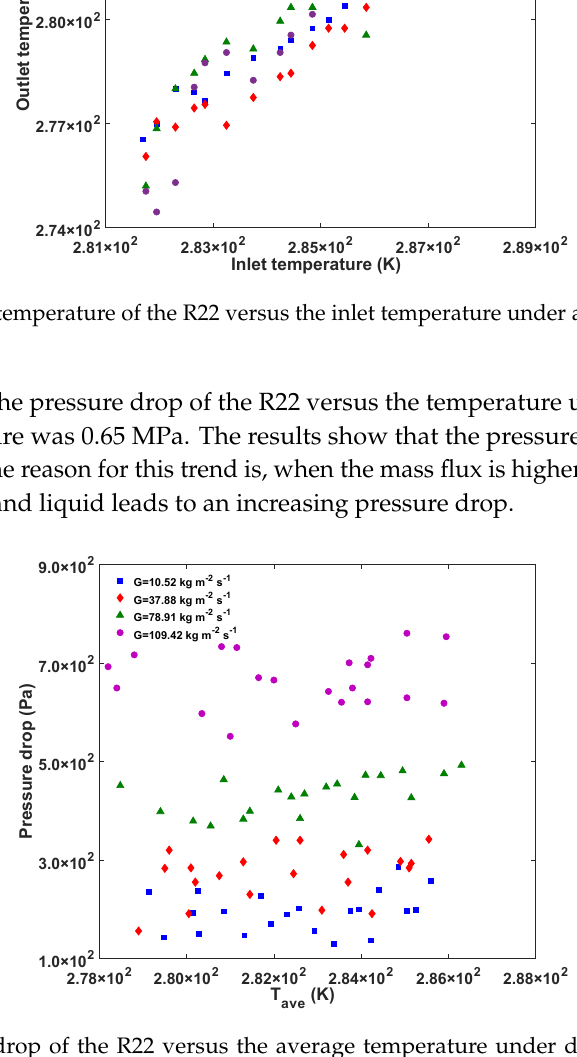
Figure 4. Pressure drop of the R22 versus the average temperature under different mass flux for p = 0.65 MPa.